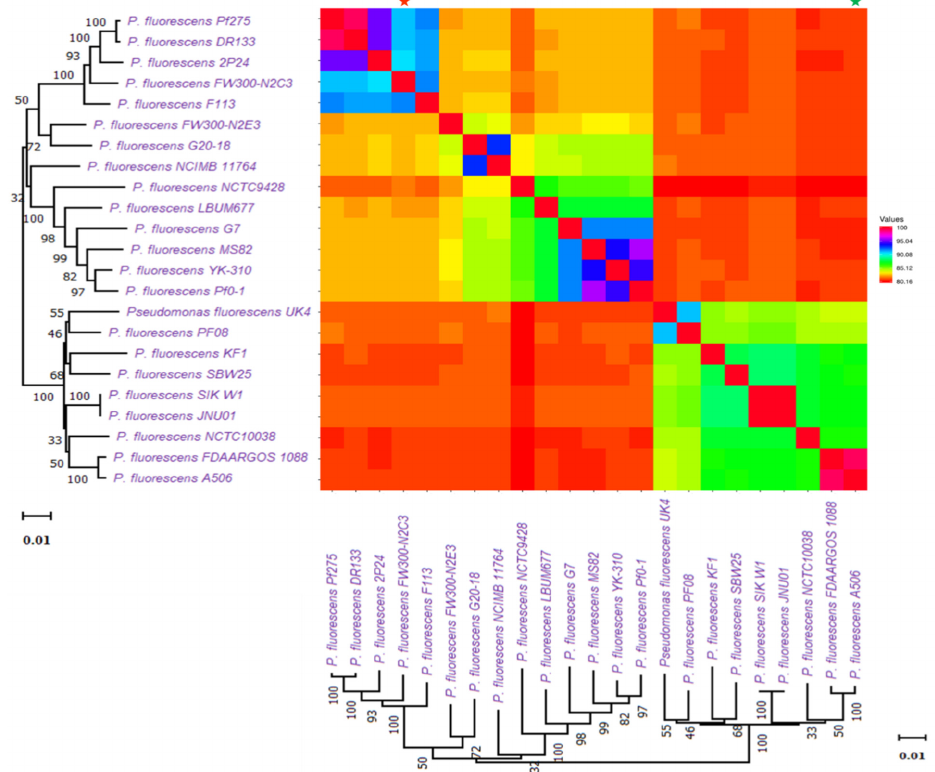
Figure 6. Whole genome similarity across the genomes of P. fluorescence sub-species. Comparison follows the same sequences as the phylogenetic tree in Figure 4. The smallest genome is marked with a * (green), and the biggest genome is marked with a * (red).